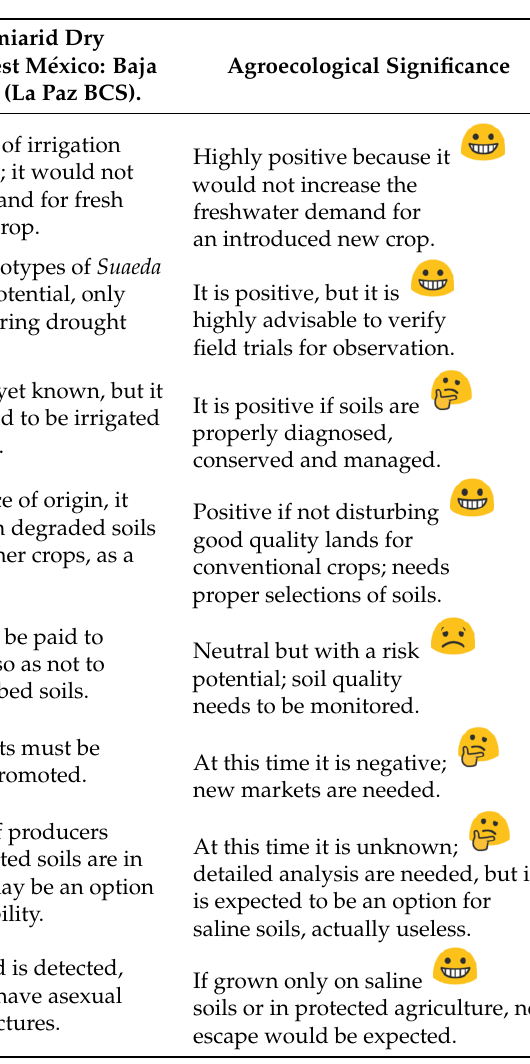
Table 4. Environmental links and possible implications associated with the introduction of Suaeda edulis (‘Romerito’) from temperate rainy zones to a semiarid region of Northwest México.